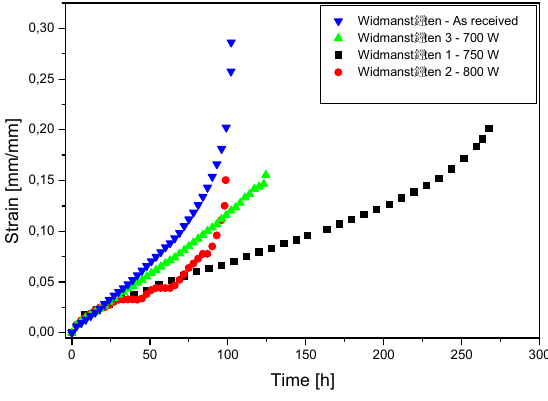
Figure 6. Creep Curves at 600 °C and 125 MPa of Ti-6Al-4V before and after laser nitriding.